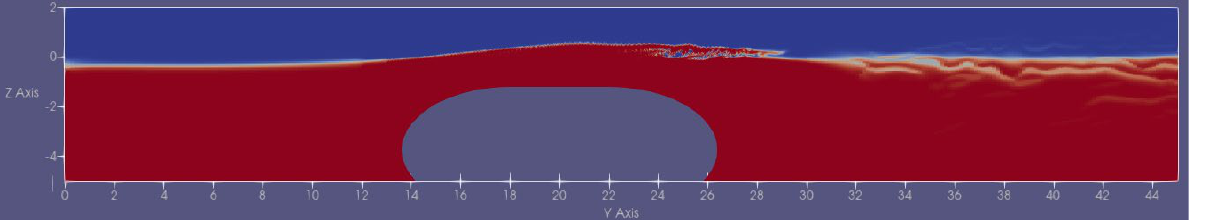
Figure 3. An example by OpenFOAM of the flume profile, showing a breaker of height 1 m over the Geotube.